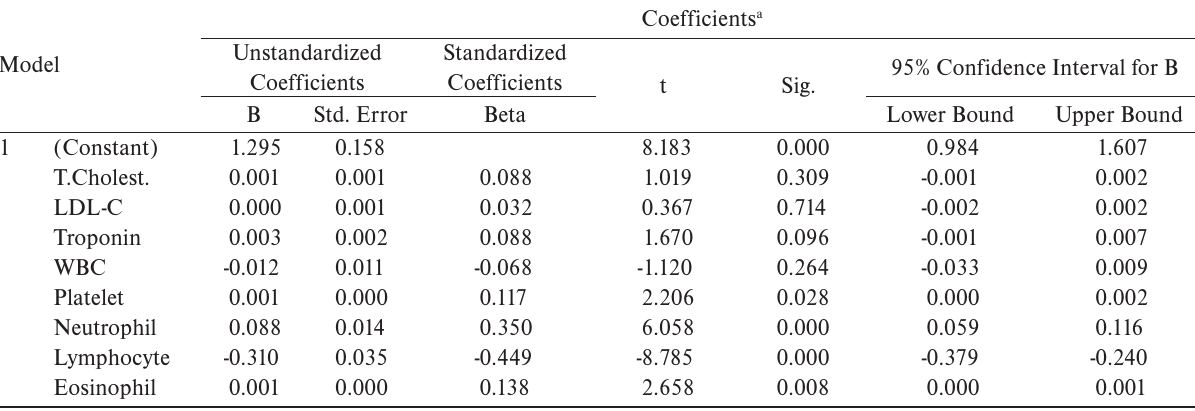
Table 4. Predictors of coronary thrombus formation in multivariate linear regression analysis.